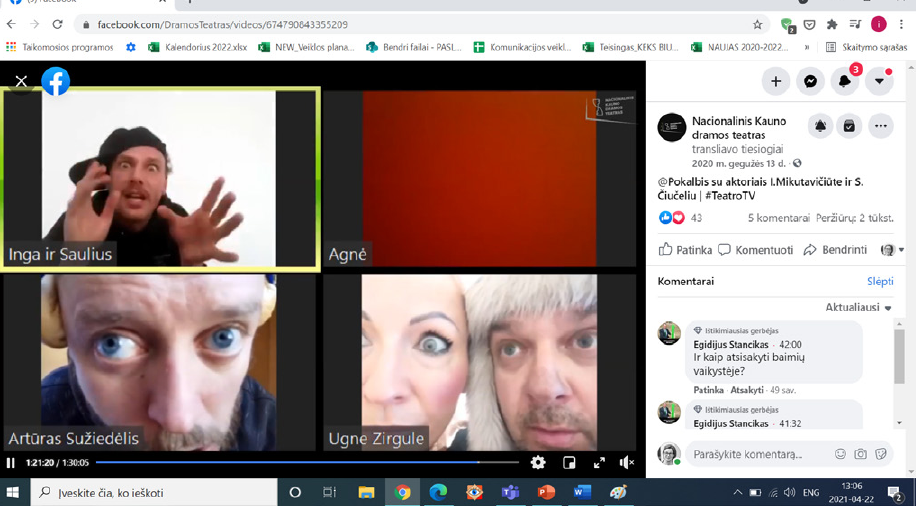
Figure 2. Performance Runaway Hare , adapted for digital communication platform. Screenshot in April, 2021 (source: created by